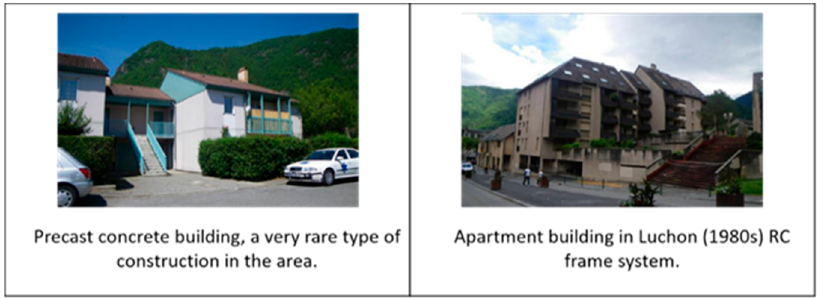
Figure A2. Residential neighborhoods and urbanizations (type T2 and T3) in the Luchon area constructed around the 1960s and 1970s.